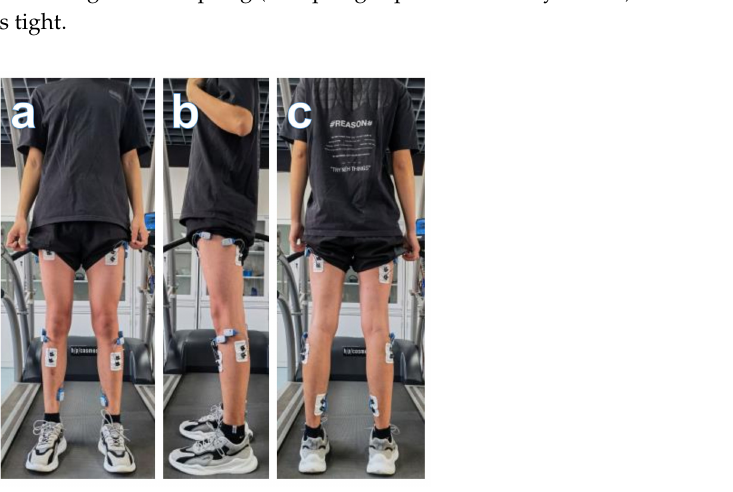
Figure 4. ( a ) Front, ( b ) side and ( c ) rear view of a participant and the placement of electrical electrodes. Walking kinematics were measured by a motion capture system (QTM, Qualysis, Gothenburg, Sweden) with sixteen lenses (OQUS500&OQUS700, Qualysis, Gothenburg, Sweden) at 300 Hz, tracking a set of 36 reflective markers (Figure 5). Markers were placed symmetrically on both sides of the anterior and posterior iliac muscles, the medial lateral condyle of knee joints, the inner and outer ankles, the heel, the first, second and fifth metatarsal bones, the thighs and the calves. The ground reaction forces (GRFs) and center of pressure (COP) were measured by a force plate (Kistler 9287C, Kistler, Winterthur, Switzerland) at 1000 Hz, which was connected to a computer through an amplifier and a data acquisition system. The physical parameters and pendulum equivalent lengths were measured and calculated according to the previous study